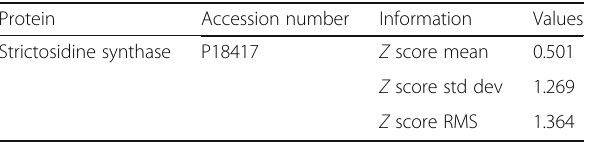
Table 7 PROVE PLOT values for STR Protein